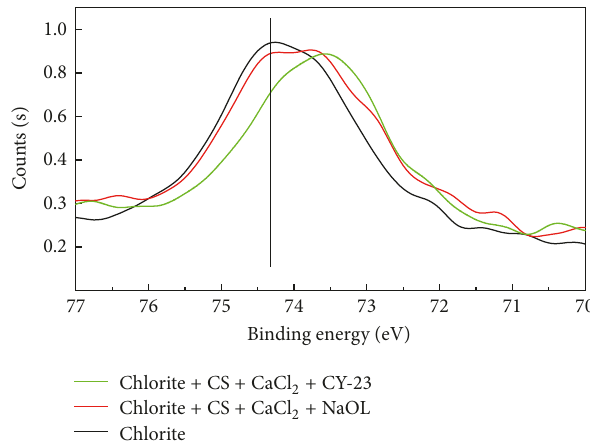
Figure 8: Mg 2p XPS full atlas before and after the reaction between chlorite and collector CY-23 or NaOL. Figure 9: Al 2p XPS full atlas before and after the reaction between chlorite and collector CY-23 or